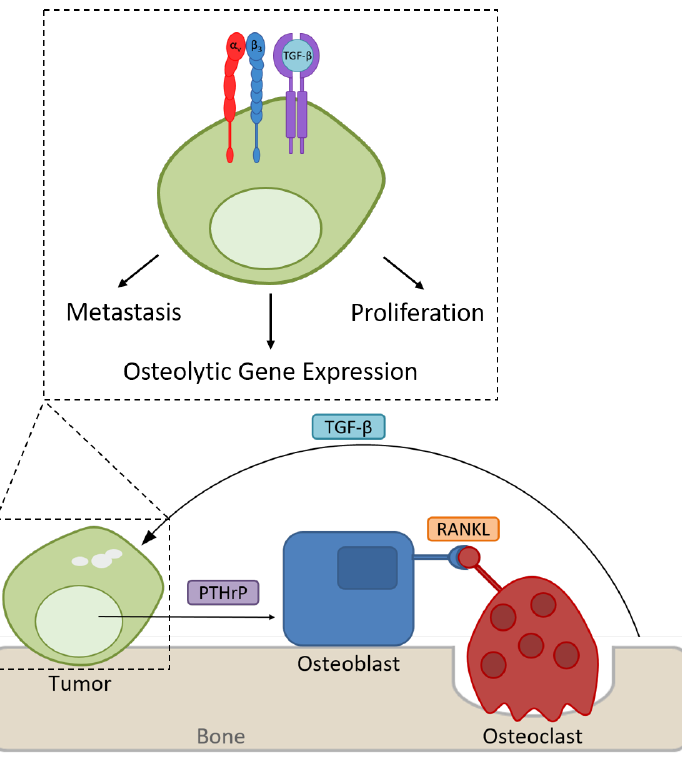
Figure 1. Expression of integrin α v β 3 promotes tumor growth and metastasis to bone. In the rigid bone microenvironment, α v β 3 interacts with TGF β RII to induce the expression of osteolytic genes such as PTHrP to stimulate osteoclast-mediated bone destruction.